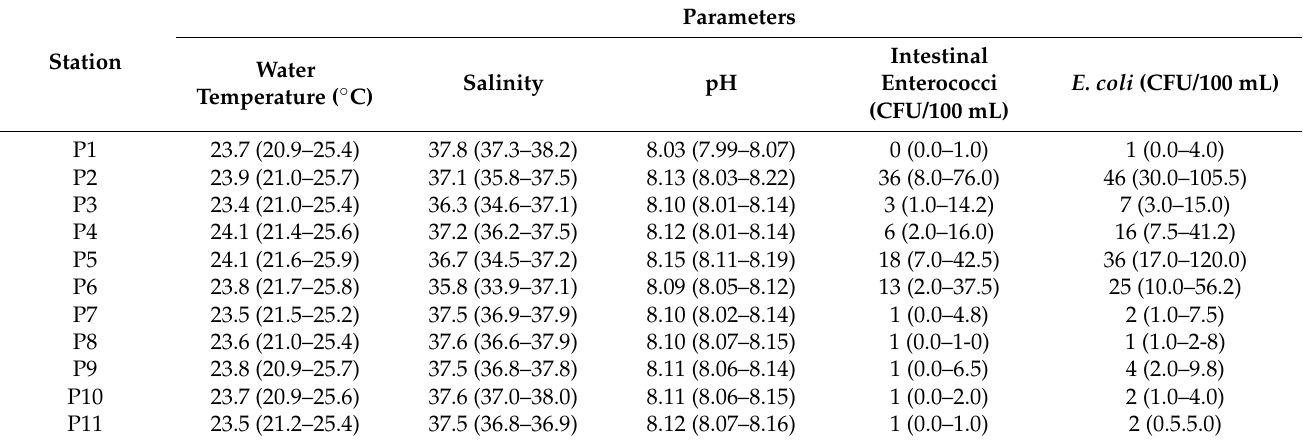
Table 1. Descriptive results (median and IQR values) of parameters measured in the